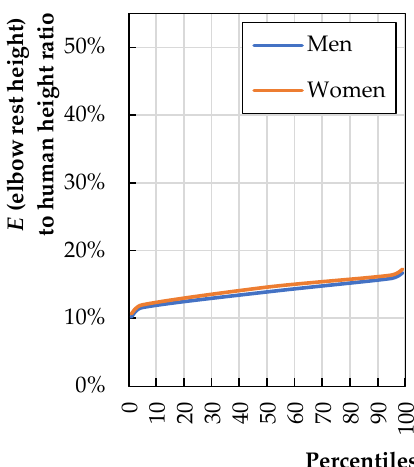
Figure 8. Elbow rest height ( E ) to total human stature ( H ) (calculations based on literature data [20]). In this case, using the mean value for the entire population seems reasonable. Dimen- sion E is 14% of the height.